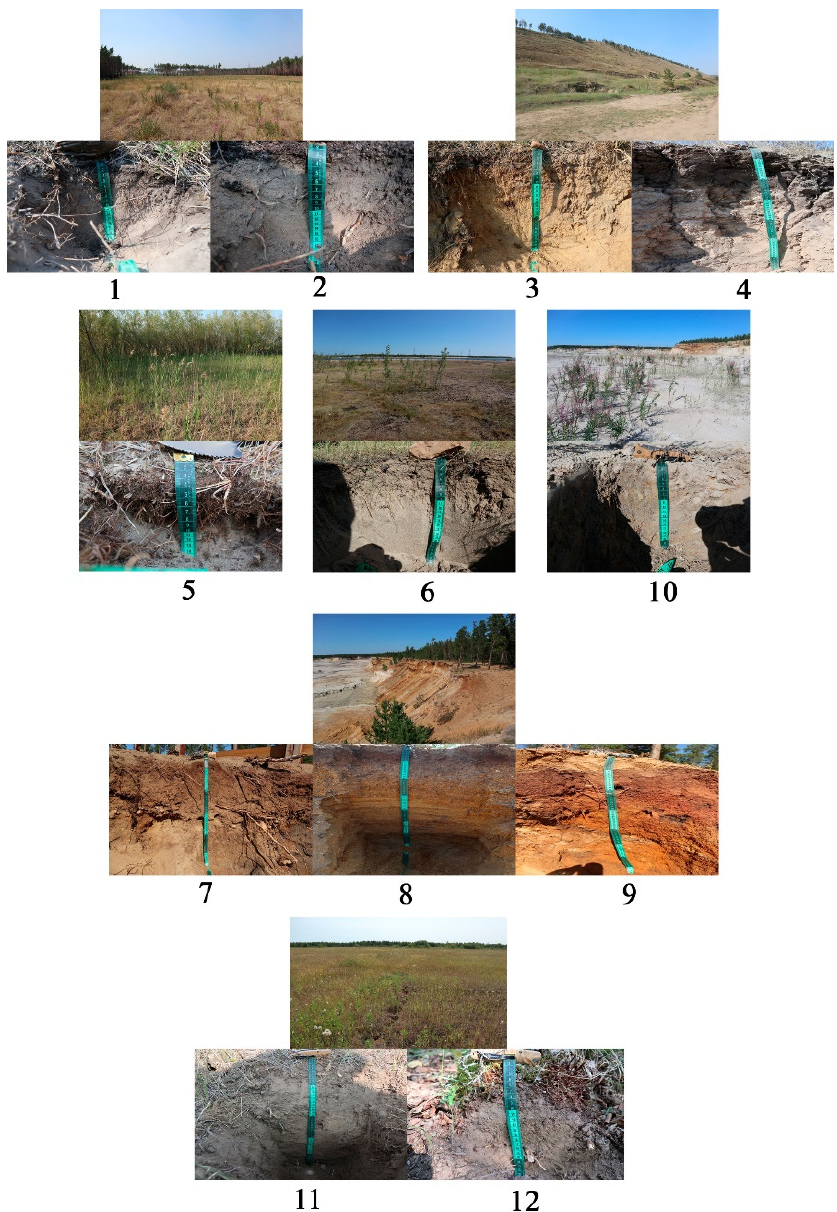
Figure 2. Soil profiles from the Yakutsk city and the adjacent territory. The soil ID correspond to Table 1.